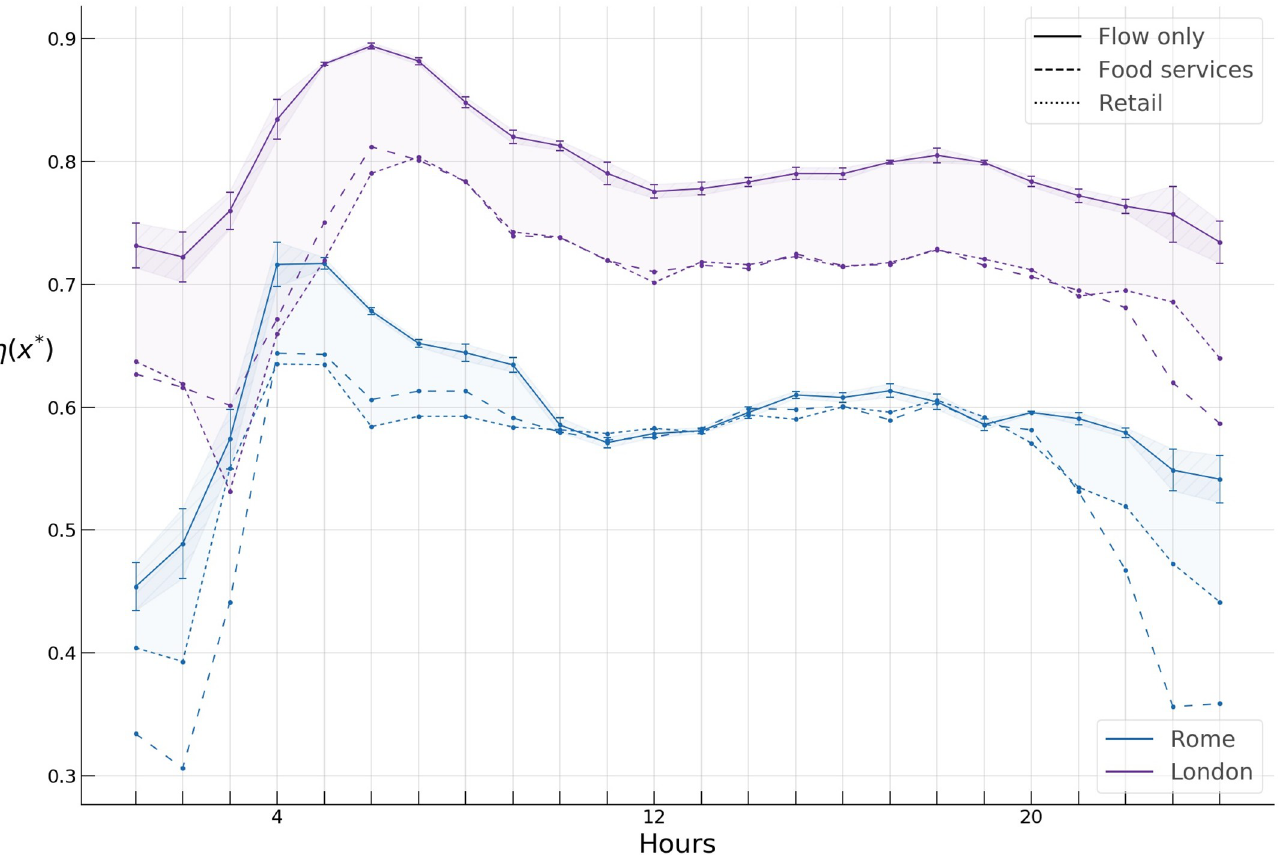
Fig 11. Spreading indices for flow only, food services, and retail activity in Rome and London during a typical